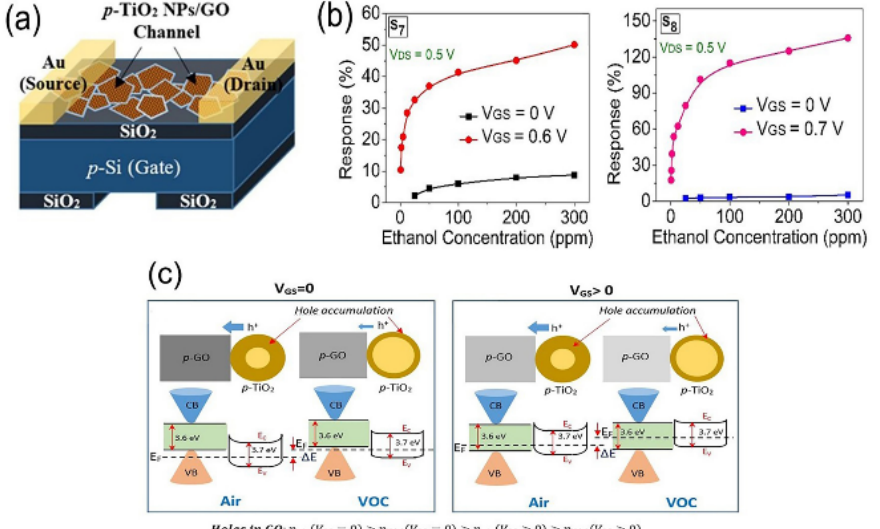
Figure 7. ( a ) Schematic diagram of a back gate FET embedded in the GO channel of p-TiO 2 NPs. ( b ) Comparison of reaction amplitude between V GS = 0 V and V GS > 0 V in (g)S7 and (h)S8 is a function of ethanol concentration. ( c ) Schematic diagram of energy band in the case of V Gs = 0 and V Gs > 0. Reproduced with permission from Ref. [54]; published by Elsevier, 2021.